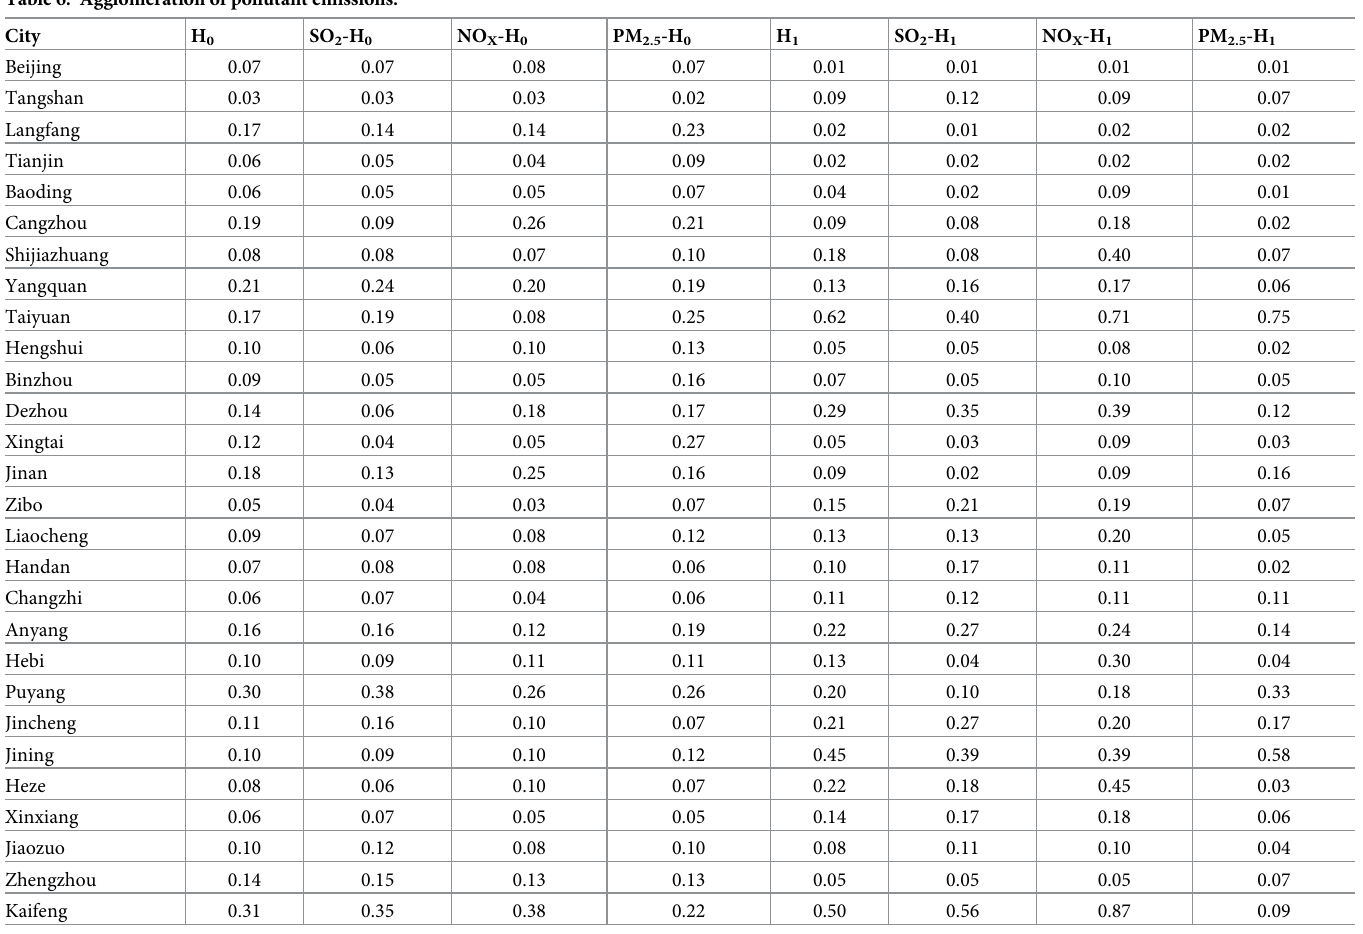
Table 6. Agglomeration of pollutant